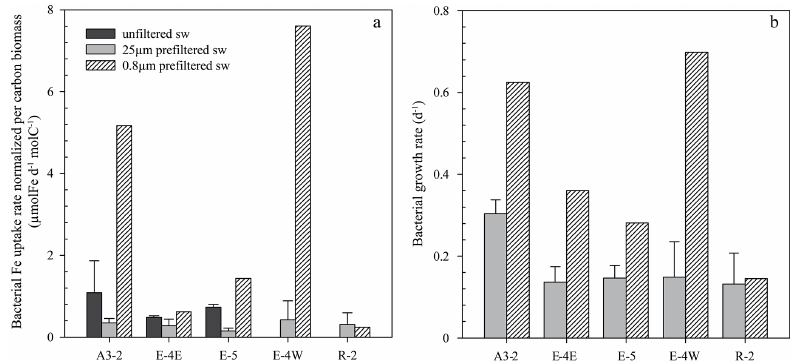
Figure 4. Bacterial Fe uptake normalized per C biomass (a) and bacterial growth rates (b) in incubations conducted with whole community (( ρ Fe:POC) whole , unfiltered seawater), with pico-nanoplankton only (( ρ Fe:POC) < 25µm , 25µm prefiltered seawater), and when bacteria bact bact were incubated alone (( ρ Fe:POC) alone , 0.8µm prefiltered seawater). As no significant effect of light on Fe uptake was observed for any bact station, we consider the values measured at the different levels of PAR as replicates. The bars for unfiltered seawater represent the aver- age ± 1SD of the three light levels (75, 25 and 1% of surface PAR). The bars for 25µm prefiltered seawater represent the average ± 1SD of all the light levels ( n = 6 for stations E-4E, E-5 and E-4W; n = 5 for stations A3-2 and R-2).